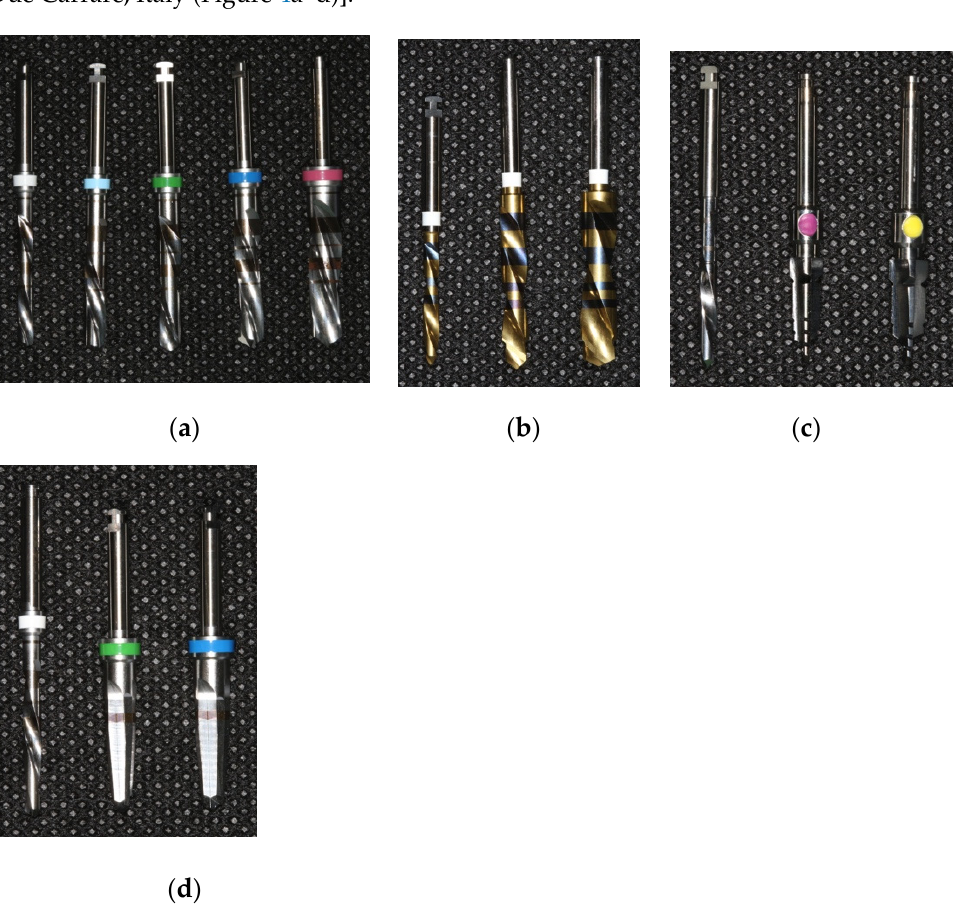
Figure 4. The two straight ( a , b ) and the two tapered ( c , d ) implant drills used in the study. The osteotomies were prepared following the manufacturers’ protocol of drill order, for the placement of a dental implant with a diameter of 5 mm × 6 mm (Table 1).